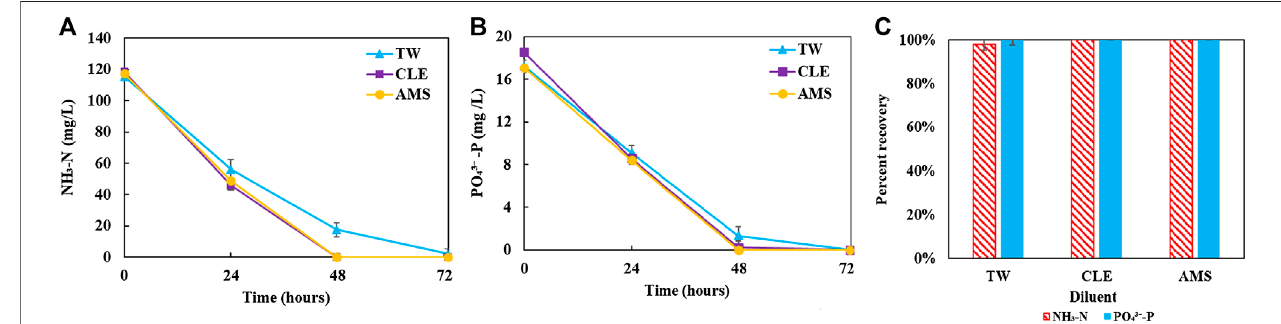
FIGURE4| Residualnutrientconcentrations: (A) inorganicammonianitrogen; (B) inorganicphosphorus; (C) recoverypercentageattheendofcultureperiod.They suggest that the coculture can effectively recover nutrient from diluted anaerobic digestion ef fl uent.